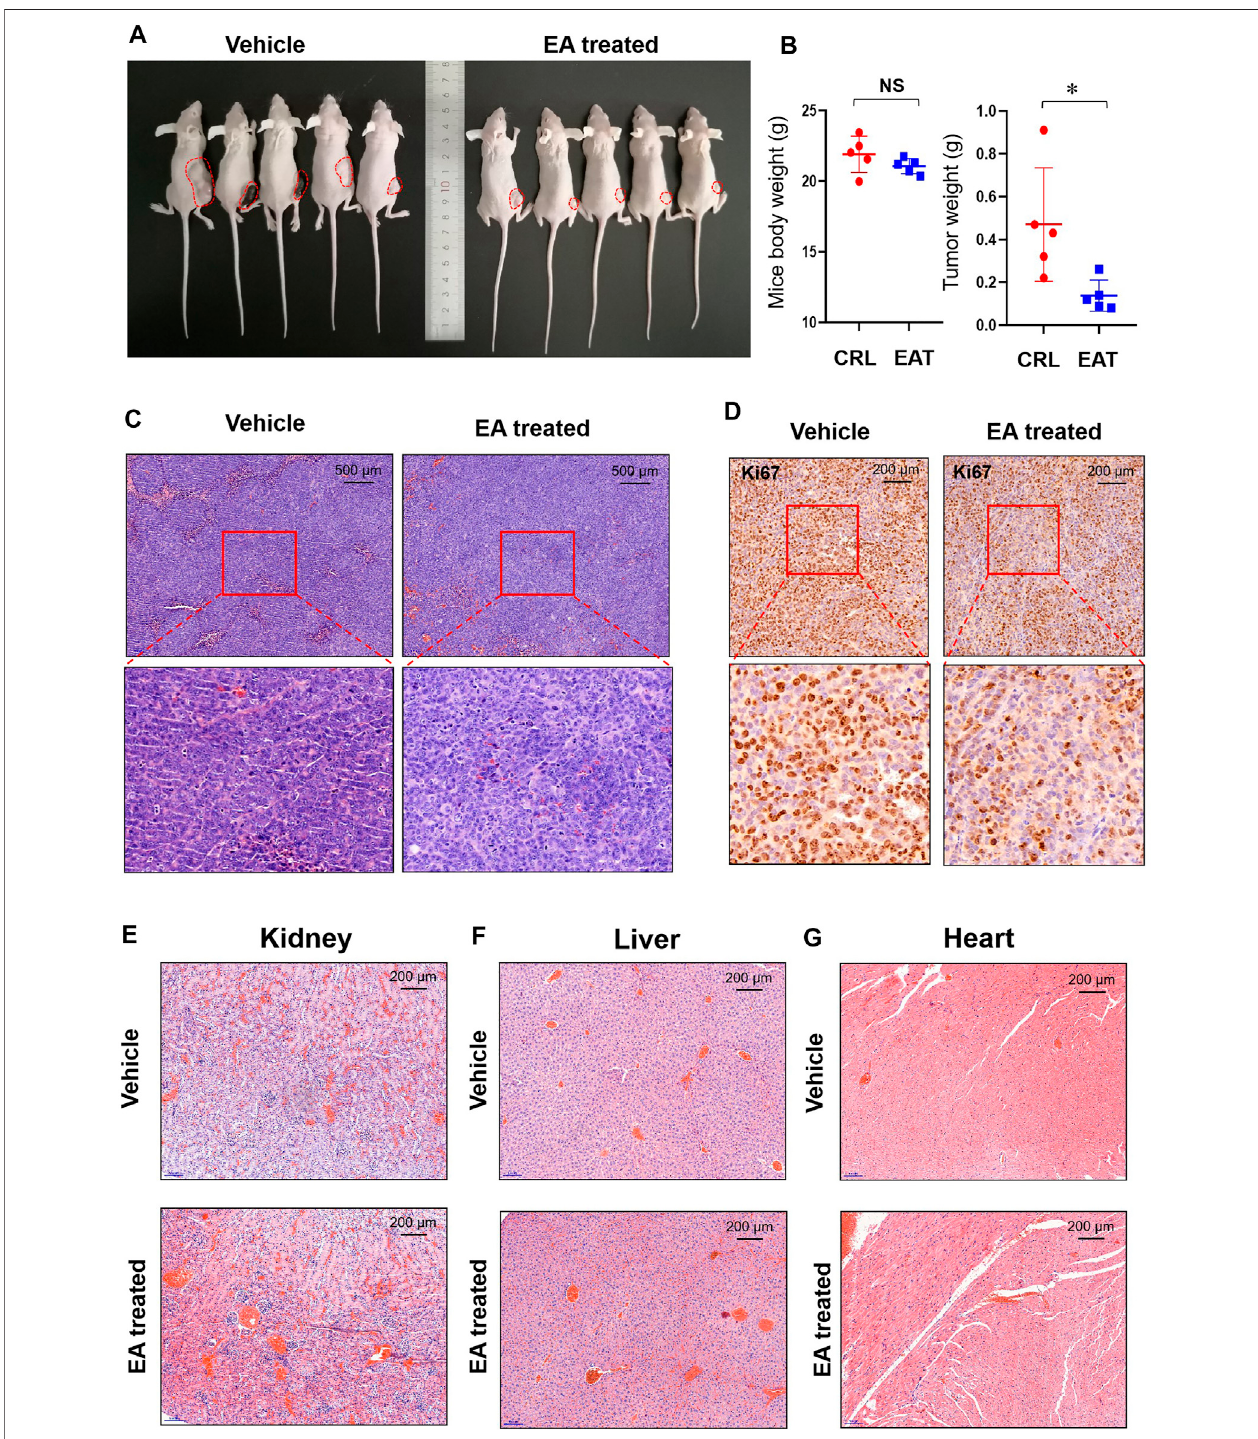
FIGURE 2 | EA repressed colorectal tumor growth in vivo . (A) After experimental mice were sacri fi ced, the xenograft tumors (marked with red dotted lines) were photographed in vivo . (B) The tumor weight and mice body weight were measured and recorded. The difference was calculated by a two-way t -test, * p < 0.05, NS means no signi fi cant difference. (C) The EA-treatment xenograft tumors and control xenograft tumors were stained using H&E. (D) Immunohistochemistry (IHC) was used to detect Ki67 in both EA-treatment group and control group, and the stained slides were photographed by a microscope. (E) The mice kidneys in EA- treatment group and control group were stained with H&E dye. (F) The mice livers in EA-treatment group and control group were stained with H&E dye. (G) The mice hearts in EA-treatment group and control group were stained with H&E dye.